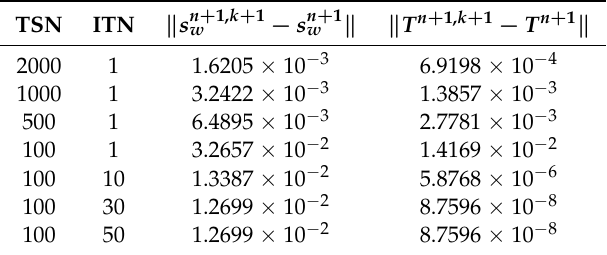
Table 2. Error estimates for different values of the time steps number (TSN) and iterations number (ITN).